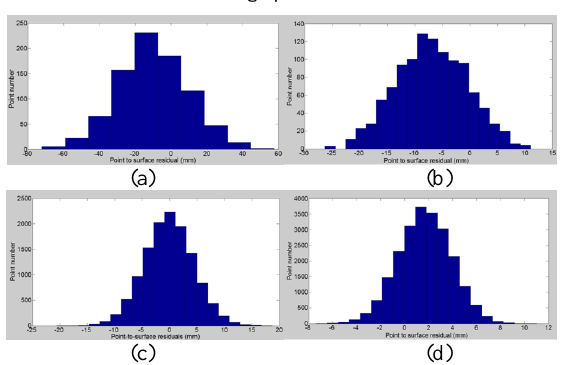
Table 4. The average point to surface residuals